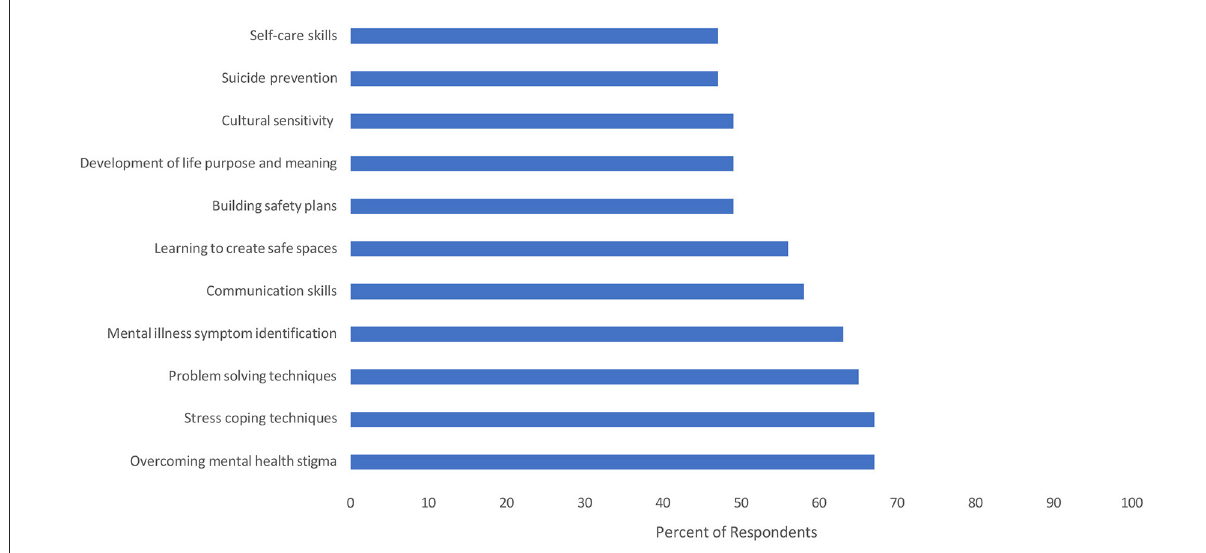
FIGURE1 Training recommendations for CHWs to address mental health needs in underserved